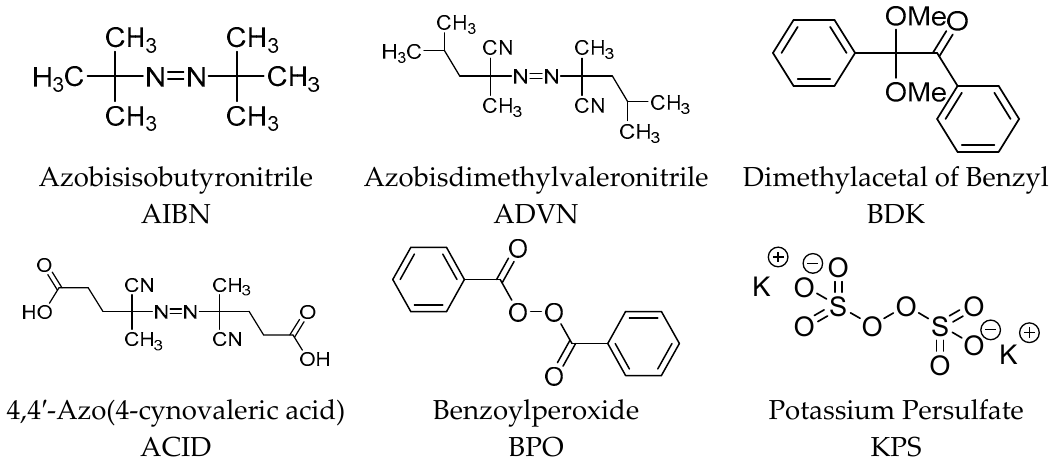
Figure 6. Structures of commonly used initiators in free radical polymerization.